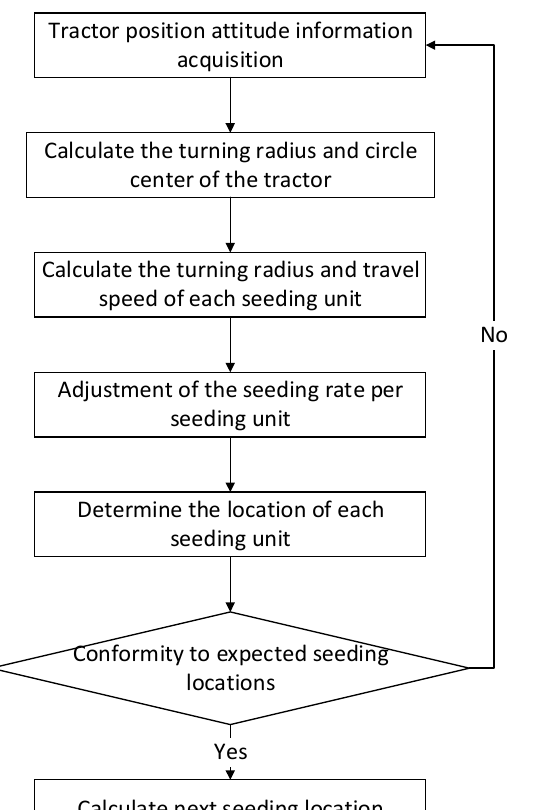
Figure 1. Overview of Device.